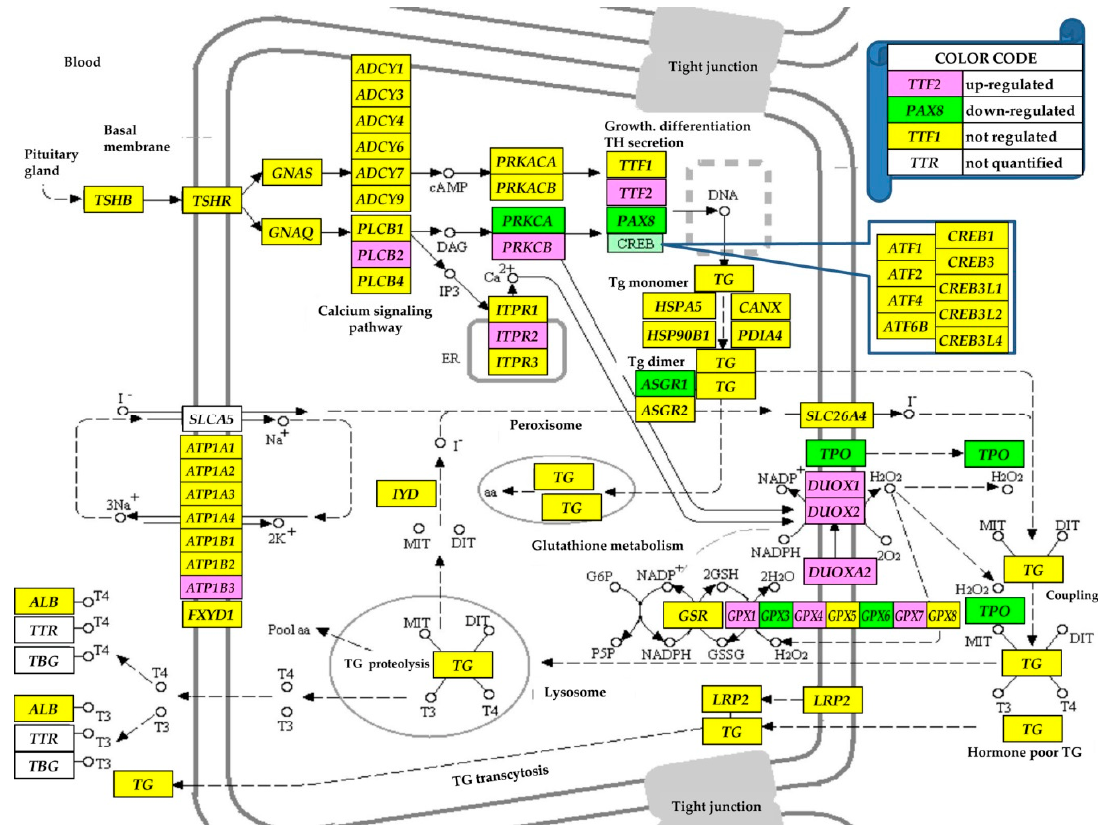
Figure 3. Regulation of thyroid hormone synthesis pathway (modified from hsa04918) . Regulated